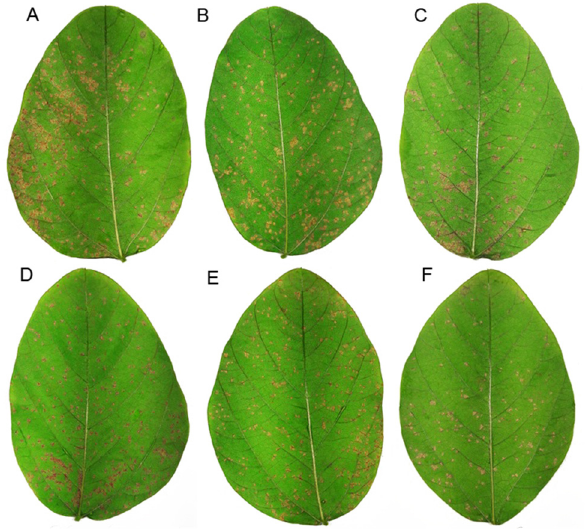
Figure 5. Lesions caused by P. pachyrhizi in soybean leaves treated with different secondary metabolites produced by Pseudomonas aeruginosa LV strain, 14 days after inoculation. The fungal spores were inoculated 24 h after treatment. ( A ) Distilled H 2 O; ( B ) DMSO + mineral oil; ( C ) F4A 20 µg mL − 1 ; ( D ) phenazine-carboxylic acid (PCA) 60 µg mL − 1 ; ( E ) phenazine carboxamide (PCN) 5 µg mL − 1 ; ( F ) organocopper compound (OAC) 0.5 µg mL − 1 .